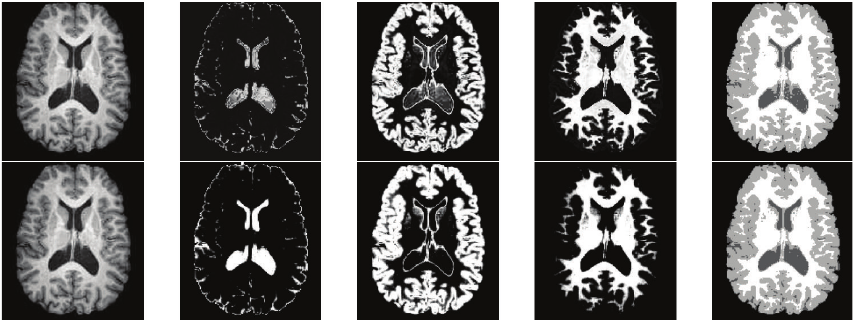
Figure 5: MRI brain image segmentations. The first line: segmentation using Shen’s model. The second line: segmentation using the proposed model. From left to right: original image, three membership functions (white matter, gray matter, and CSF (cerebrospinal fluid)), and hard segmentations, respectively.